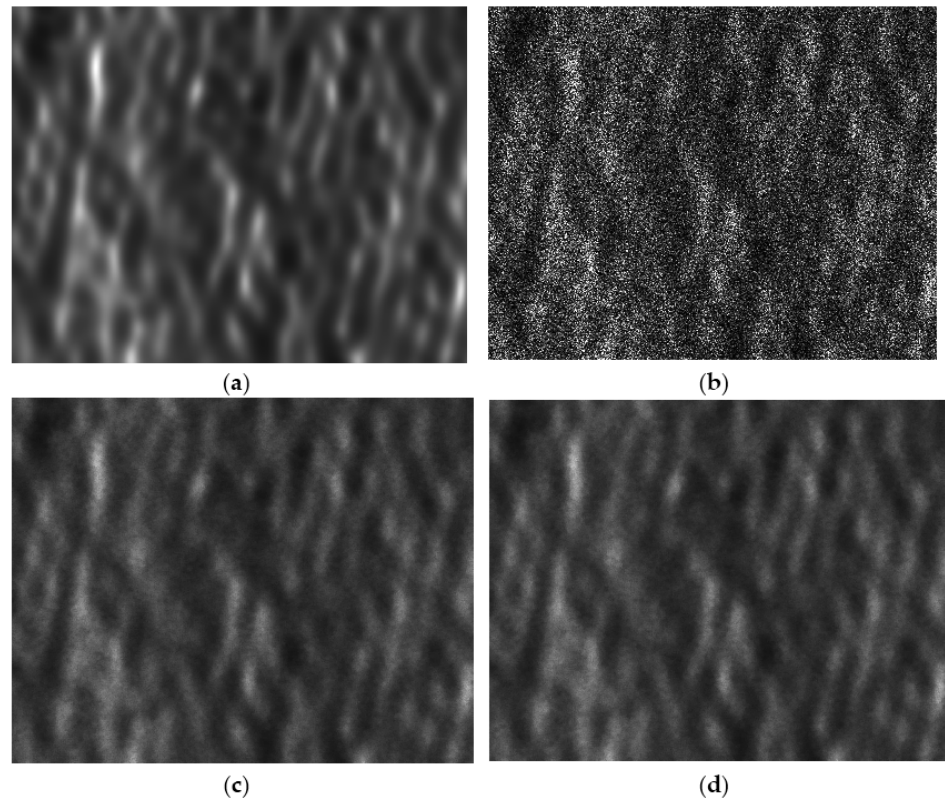
Figure 12. Simulated SAR image ( a ) speckle-free (Cx = 0.315) and ( b ) with speckle (Cx = 1.095), for the fractal DEM in Figure 11. Despeckled image ( c ) using SB-PPB (Cx = 0.320, RT = 360 s), ( d ) PPB with four iterations (Cx = 0.320, RT = 642 s).